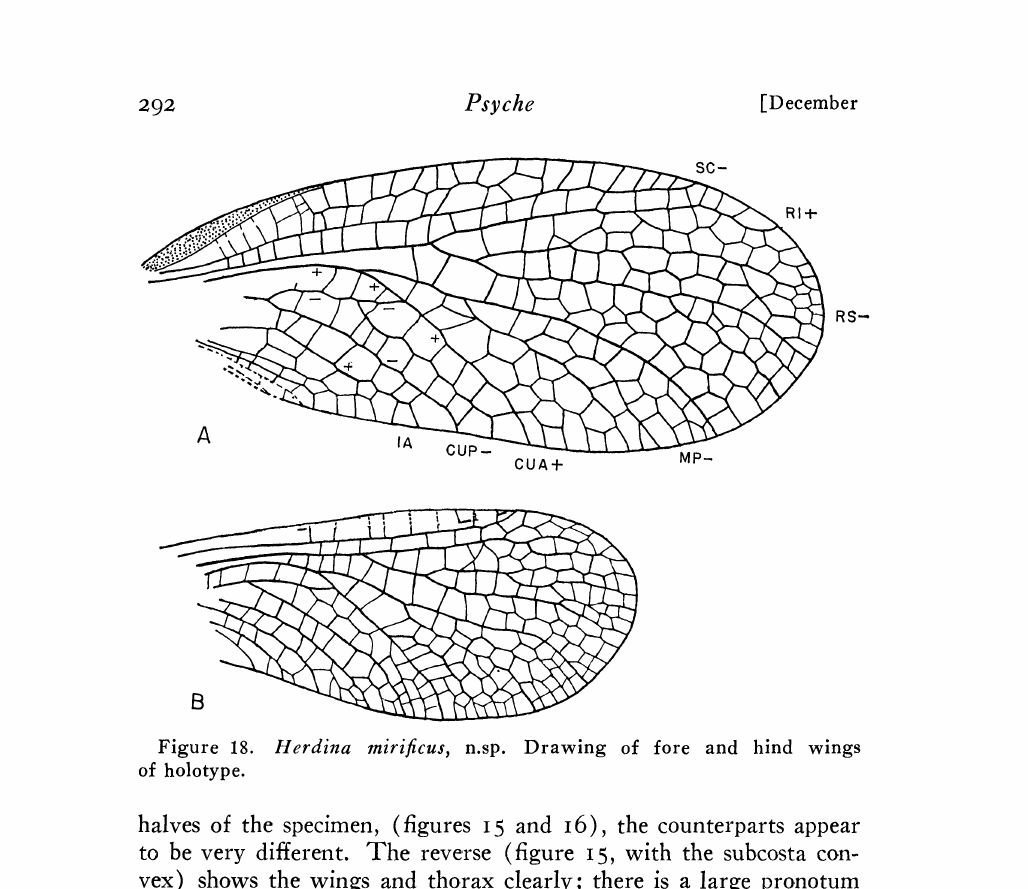
Figure 18. Herdina mirificus, n.sp. Drawing of fore and hind wings